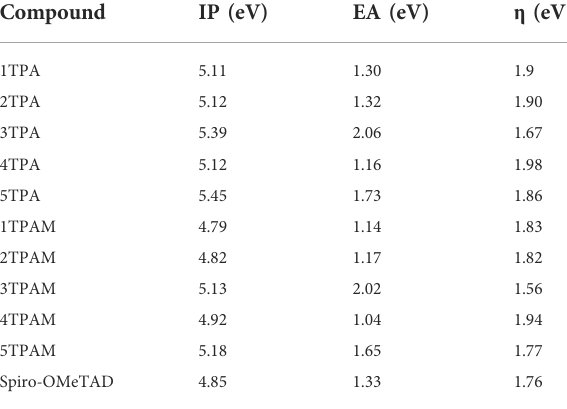
TABLE 4 Chemical reactivity parameters of the triphenylamine derivatives and Spiro-OMeTAD calculated with M06/6- 311++G(d,p).